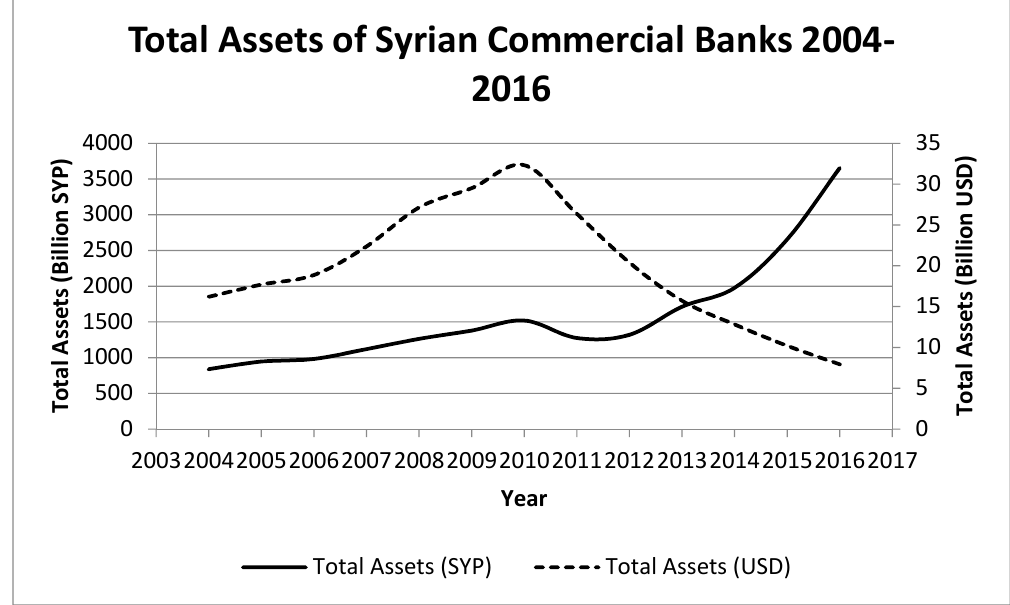
Figure 1. Total Assets of Syrian Banks. Note: The figure shows the total assets of Syrian banks spanning the period 2004–2016.